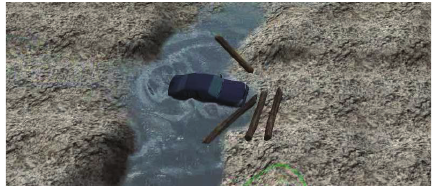
Figure 1: A car crossing a river with floating logs. The car, imple- mented with our method, blocks water and causes huge waves. The logs are floating bodies implemented with the method of [11] that have a limited effect on the